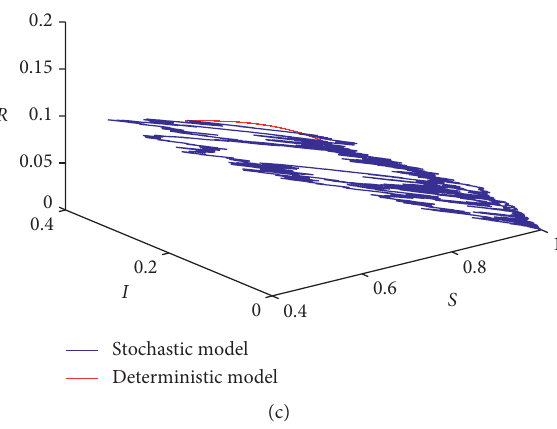
Figure 4: (a) Deterministic system, (b) corresponding stochastic systems of (a), and (c) the phase portrait of (b). (a) σ � 0 . 85 , σ � 0 . σ 1 2